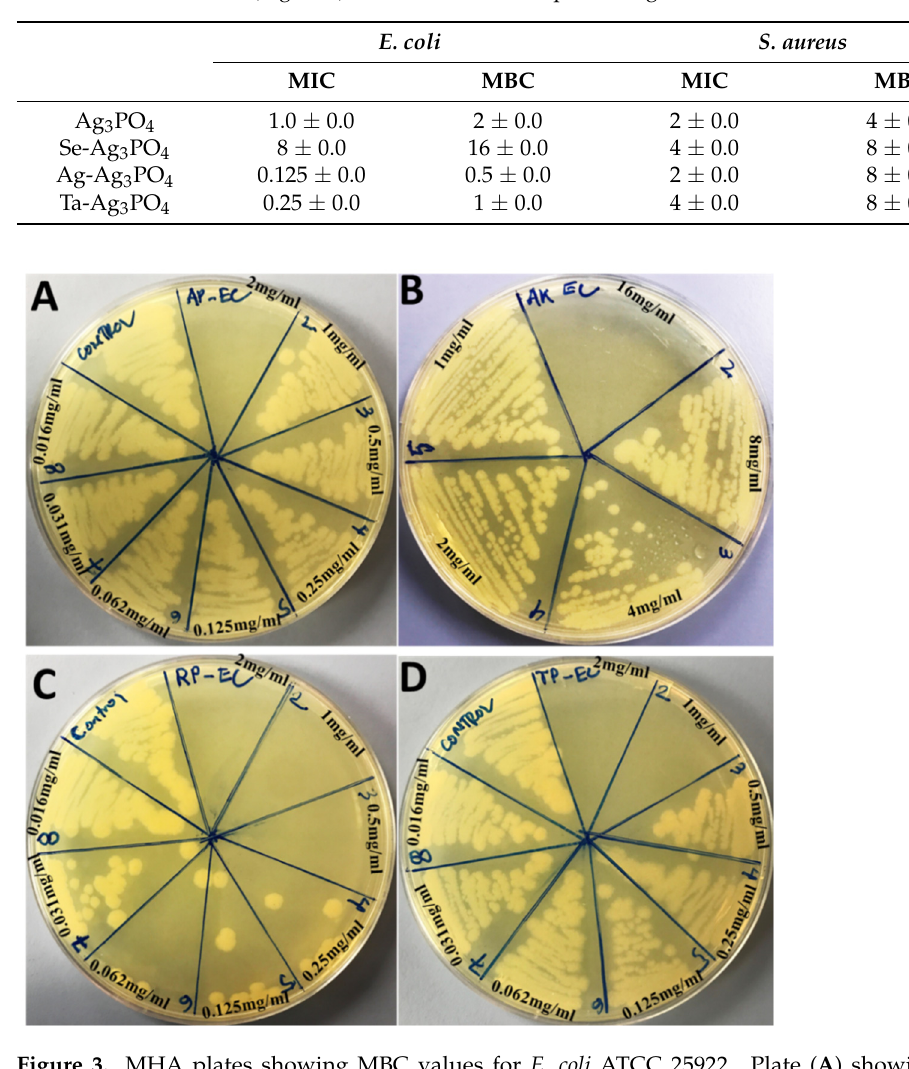
Figure 4. MHA plates showing MBC values for S. aureus ATCC 25923. Plate ( A ) showing MBC value of 4 mg/mL for Ag 3 PO 4 , ( B ) 8 mg/mL for Se-Ag 3 PO 4 , ( C ) 8 mg/mL for Ag-Ag 3 PO 4 , and ( D ) 8 mg/mL for Ta-Ag 3 PO 4 , respectively.